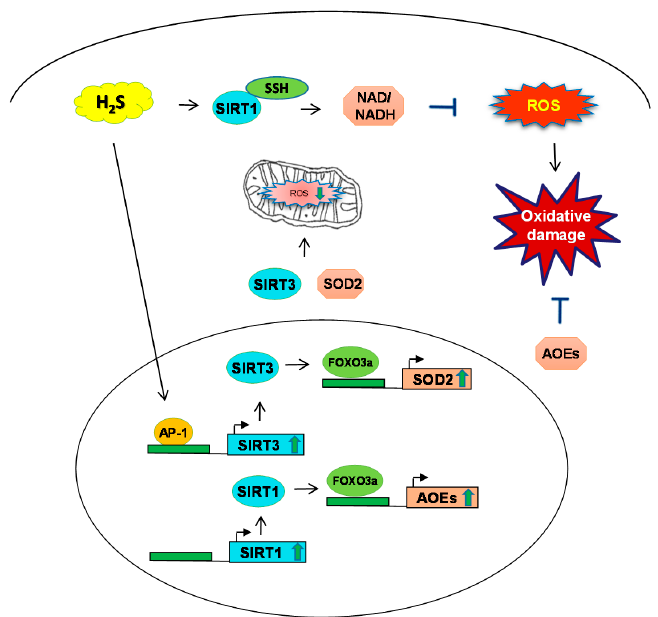
Figure 3. Schematic of H 2 S mechanism and sirtuins SIRT-1 , SIRT-3 during oxidative stress. H 2 S induces SIRT1 to regulate the levels of nicotinamide adenine dinucleotide and nicotinamide adenine dinucleotide phosphate NAD/NADH to prevent ROS generation. SIRT-3 induces the expression of transcription factor FOXO3 and consequent ROS production. Additionally, H 2 S has been shown to induce SOD2 through SIRT3 in mitochondria and regulate oxidative stress. SSH: S-sulfhydration; AP-1: activator protein-1.